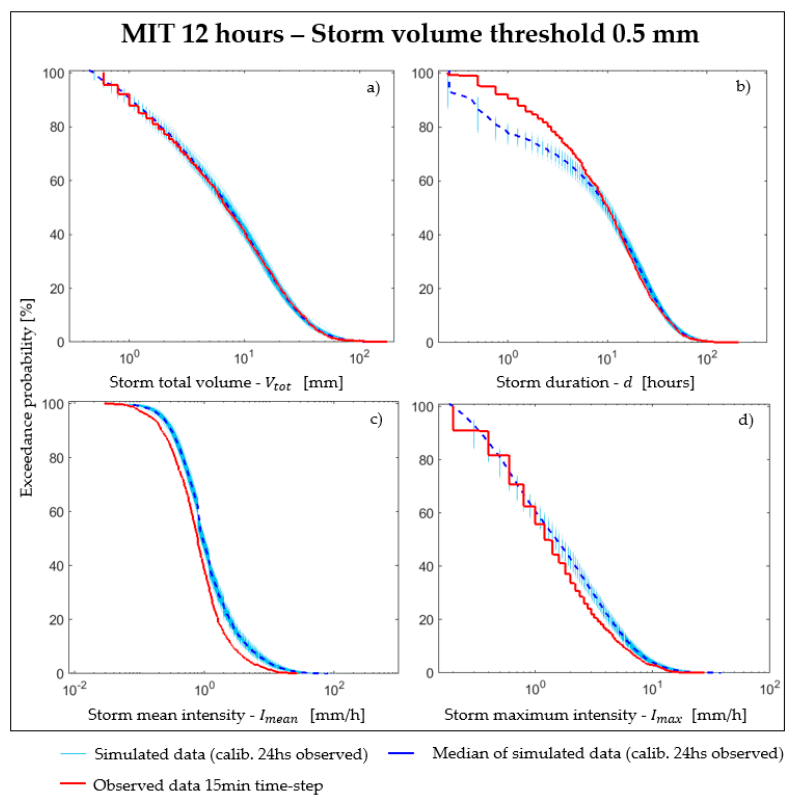
Figure 5. Key Characteristics of rainfall pattern calculated using a MIT of 12 h and a storm volume threshold of 0.5 mm: ( a ) storm total volume [mm]; ( b ) duration of the storm event [hours]; ( c ) storm mean intensity [mm/h]; ( d ) storm maximum intensity [mm/h].